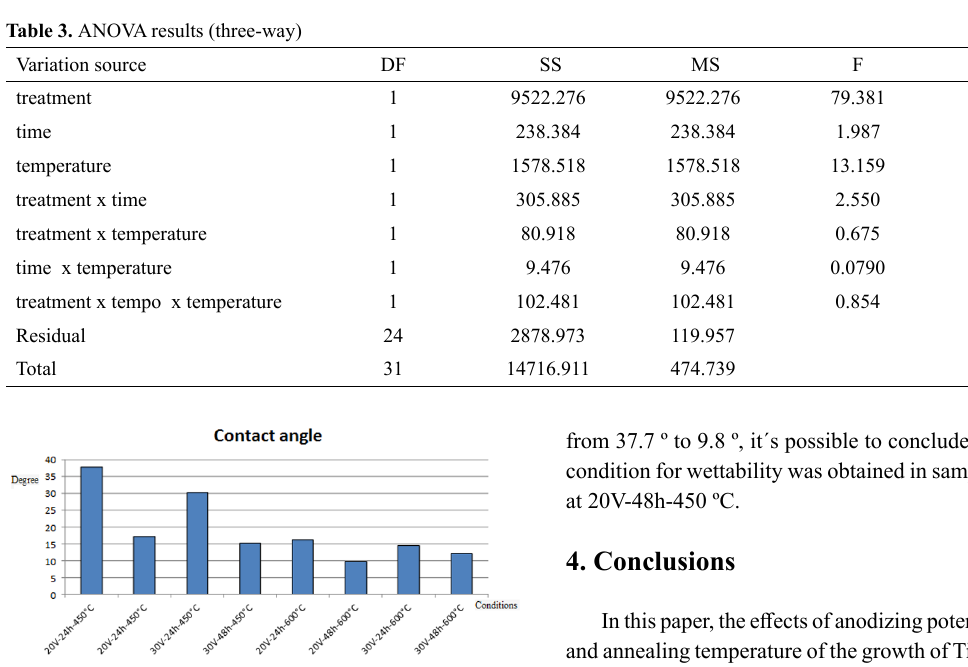
Figure 7. Contact angle measurements for all conditions studied